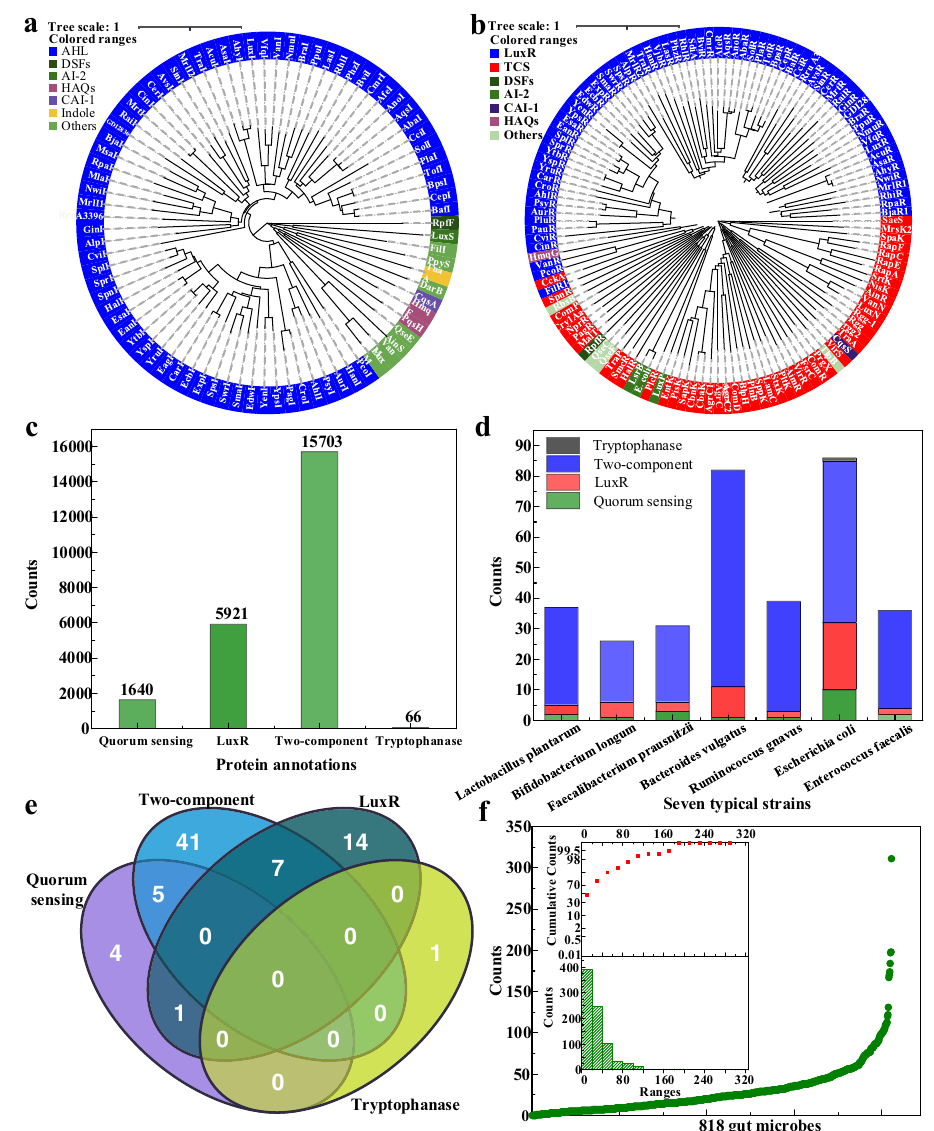
Fig. 2 Results of collections of the reported and annotated QS entries. Evolutionary trees of QS synthases ( a ) and receptors ( b ). a The optimal tree with the sum of branch length = 40.33 is shown. This analysis involves 84 amino acid sequences, and there are a total of 1374 positions in the fi nal dataset. b The optimal tree with the sum of branch length = 91.14 is shown. This analysis involves 129 amino acid sequences, and there are a total of 1010 positions in the fi nal dataset. c Total QS&TCS entries with four protein annotations, i.e., “ quorum sensing ” , “ LuxR ” , “ two-component ” , and “ tryptophanase ” . d QS&TCS entries distribution of the seven-strain simpli fi ed human gut microbes used by Colosimo et al. 42 . e The overlap of the four types of QS&TCS entries in Escherichia coli O157:H7 strain. f QS&TCS entries count distribution of 818 human gut microbes from the VMH database 28 . Note that the subgraph indicates the cumulative distribution curve for the statistics of the collected QS&TCS entries. The upper and lower insets show the probabilities and histogram, respectively. “ Ranges ” in the subgraph shows the range of the number of QS&TCS entries contained in each strain. The “ Counts ” and “ Cumulative counts ” in the subgraph represents the speci fi c number of strains and proportion, respectively. Source data are provided as a Source Data fi